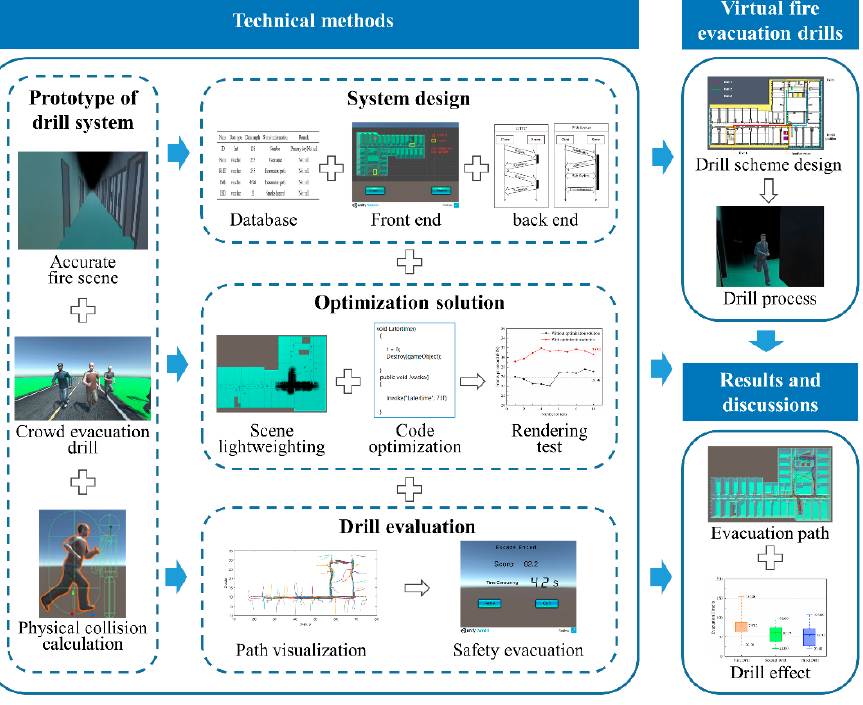
Figure 1. Framework of this study .